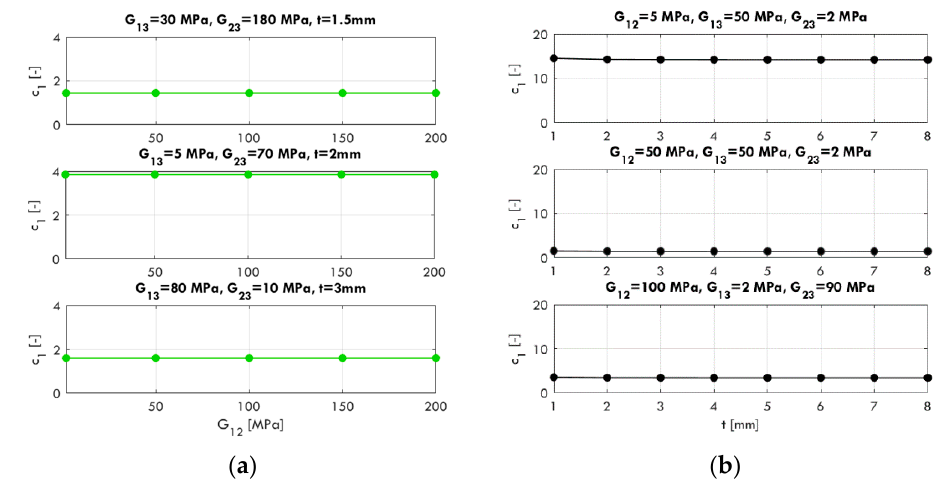
Figure 4. Influence of G 12 ( a ) and e ff ective thickness t ( b ) on the value of the c 1